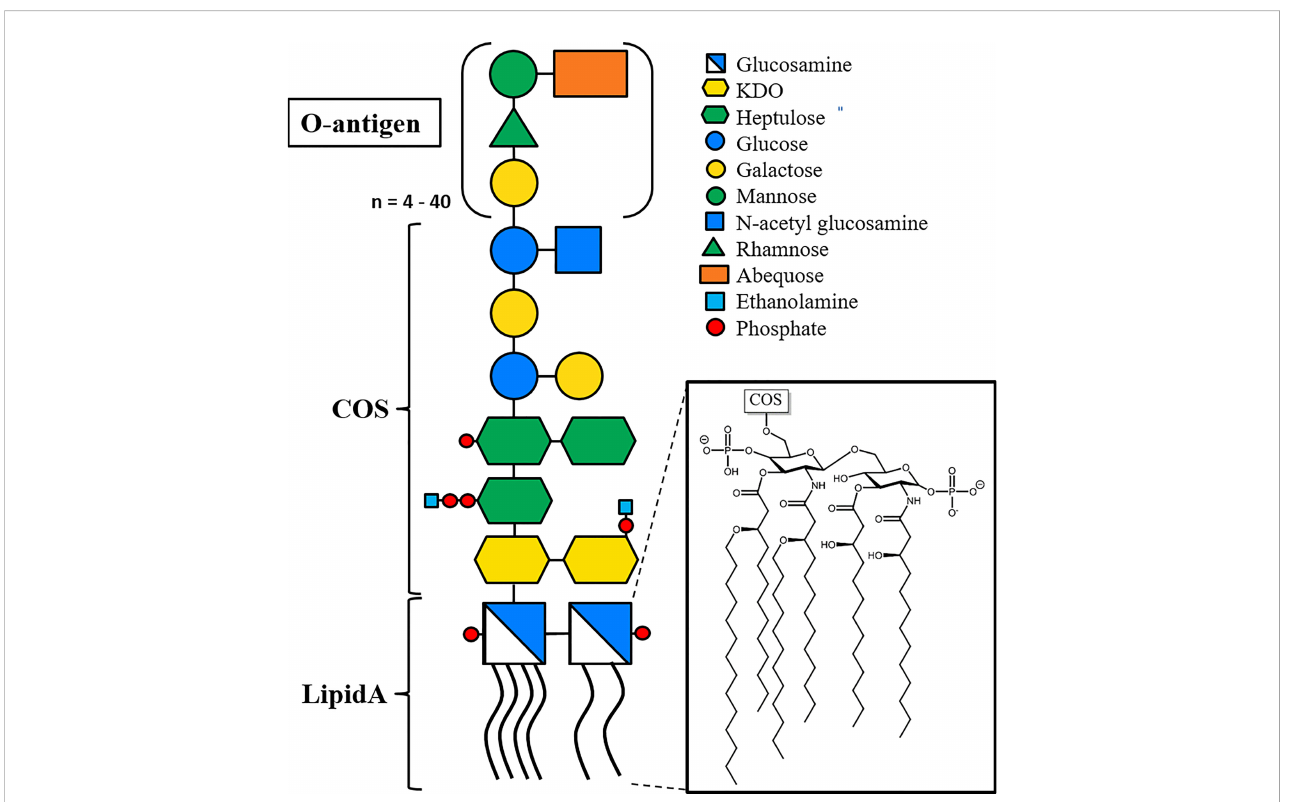
FIGURE 2 Representative structure of LPS, based on LPS from Salmonella enterica sv. Typhimurium. The membrane-embedded lipid A moiety (insert) consists of two phosphoglucosamines with four O-linked and two N-linked acyl chains. The core oligo saccharide (COS) is linked to lipid A via a glycosidic bond, and the O-antigen linked to the penultimate COS sugar. The O-antigen consists of a four-sugar repeat varying between 4 and 40 repeat units, with an average of 30 repeats(Peterson and McGroarty, 1985). Lipid A and the two proximal 3-Deoxy-D-manno-oct-2-ulosonic acid (KDO) sugars are highly conserved among Gram-negative species, while the rest of COS and O-antigen are conserved among bacterial species and serotypes, respectively. Glycans are shown using the Consortium for Functional Glycomics (CFG)